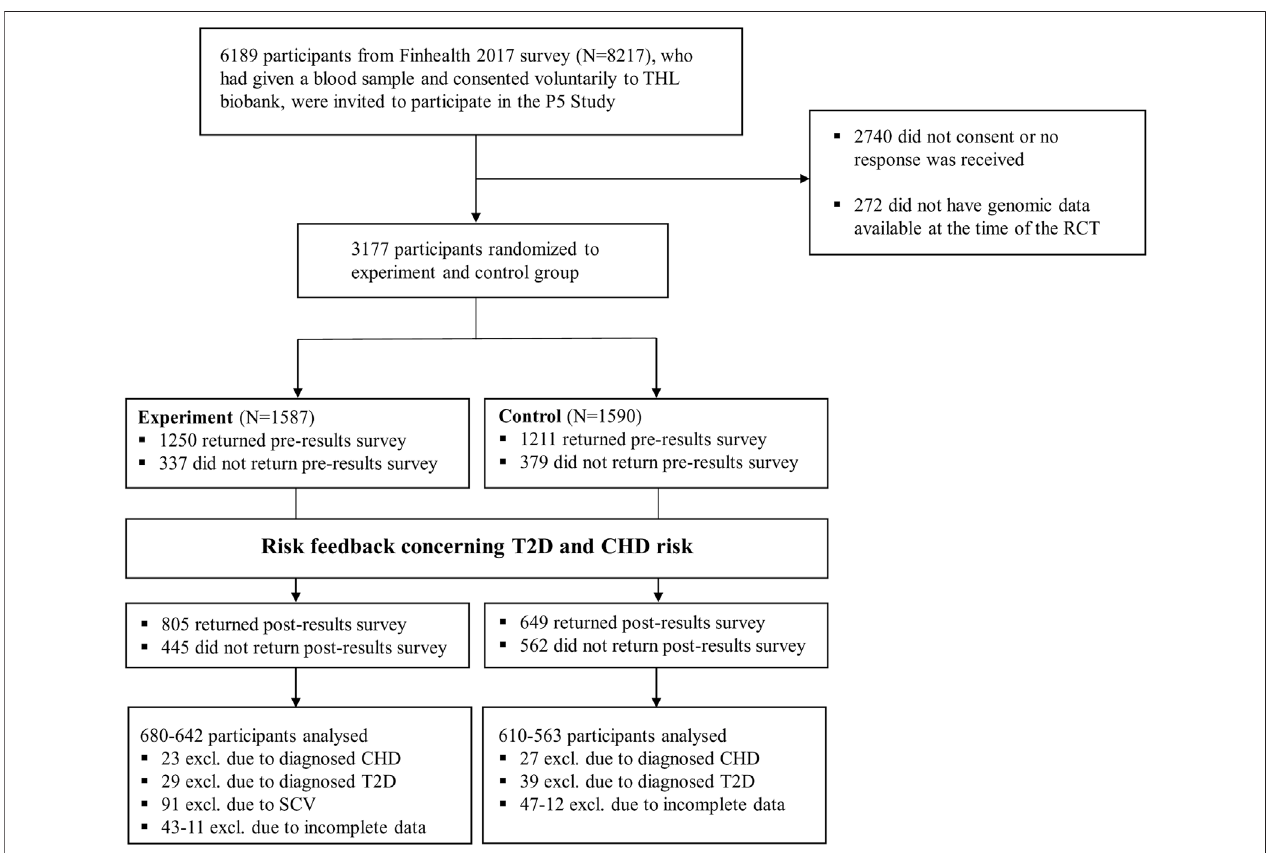
FIGURE 1 | Flowchart for the current